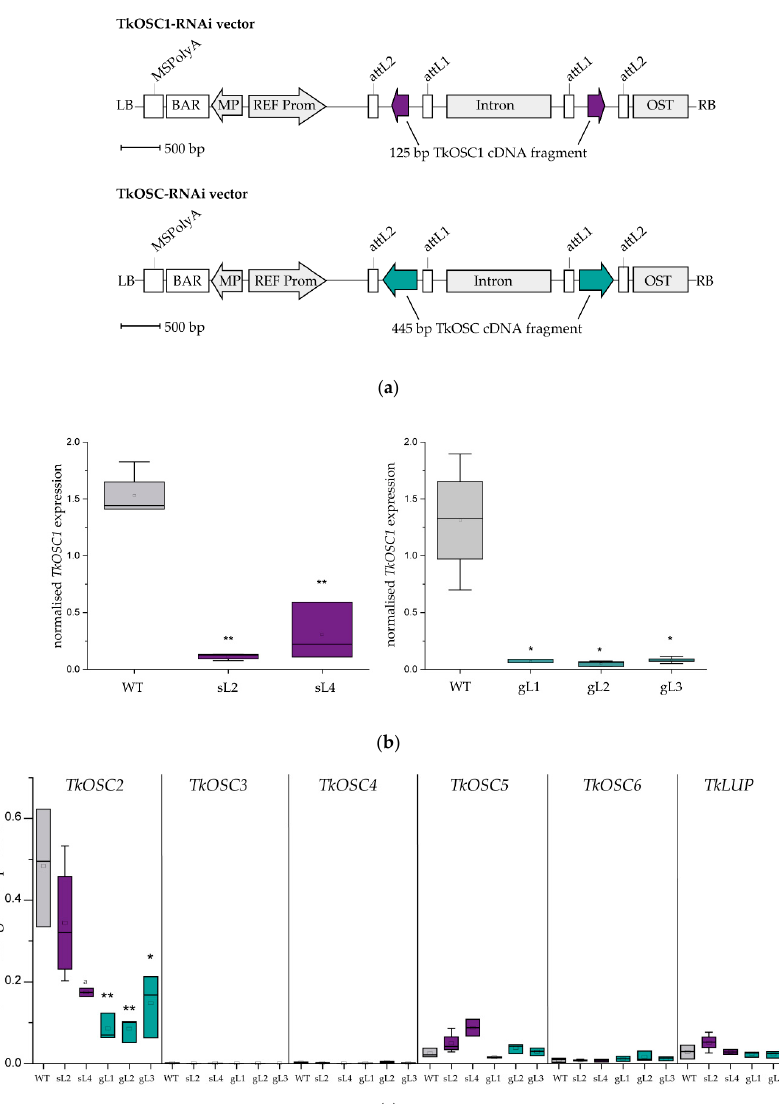
Figure 2. RNA silencing of TkOSCs in T. koksaghyz . ( a ) Schematic representation of TkOSC1 - and TkOSC -RNAi vectors. A 125 bp cDNA fragment deriving from a non-conserved region was supposed to knock down TkOSC1 expression only, whereas a 445 bp-cDNA fragment derived from a more conserved region was expected to knock down several TkOSCs . REF Prom: laticifer-predominant promoter of the rubber elongation factor (REF); att L1 / 2: att L cassette frame; BAR: basta resistance gene; Intron: chalcone synthase intron from P. hybrida ; LB: left border; MP: mannopine synthase promoter; MSPolyA: mannopine synthase poly(A) signal; OST: octopine synthase poly(A) signal; RB: right border; ( b ) and ( c ) Quantitative real-time PCR of TkOSCs in latex from roots of transgenic TkOSC1 -RNAi lines (sL), TkOSC -RNAi lines (gL) and wild-type (WT) plants; the expression levels were normalized to the constitutive genes encoding elongation factor 1a ( TkEF1a ) and ribosomal protein L27 ( TkRP ) from T. koksaghyz . Asterisks denote statistical significance compared to control (two-tailed t test, * p < 0.05, ** p < 0.01). ( b ) normalized TkOSC1 expression in wild-type and TkOSC 1 / TkOSC -RNAi plant lines ( n = 3–8). ( c ) normalized expression of further TkOSC genes in all transgenic lines compared to WT ( n = 2–4), a n =